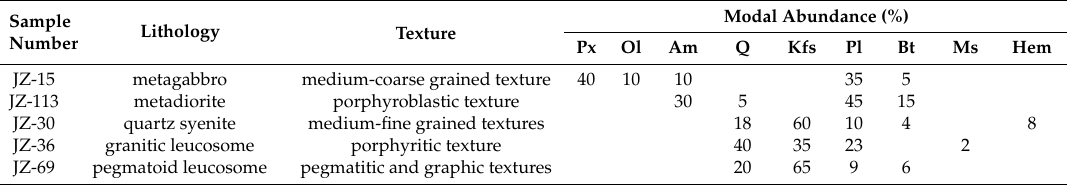
Table 1. Modal abundance (%) of minerals for different rock types in LS area.